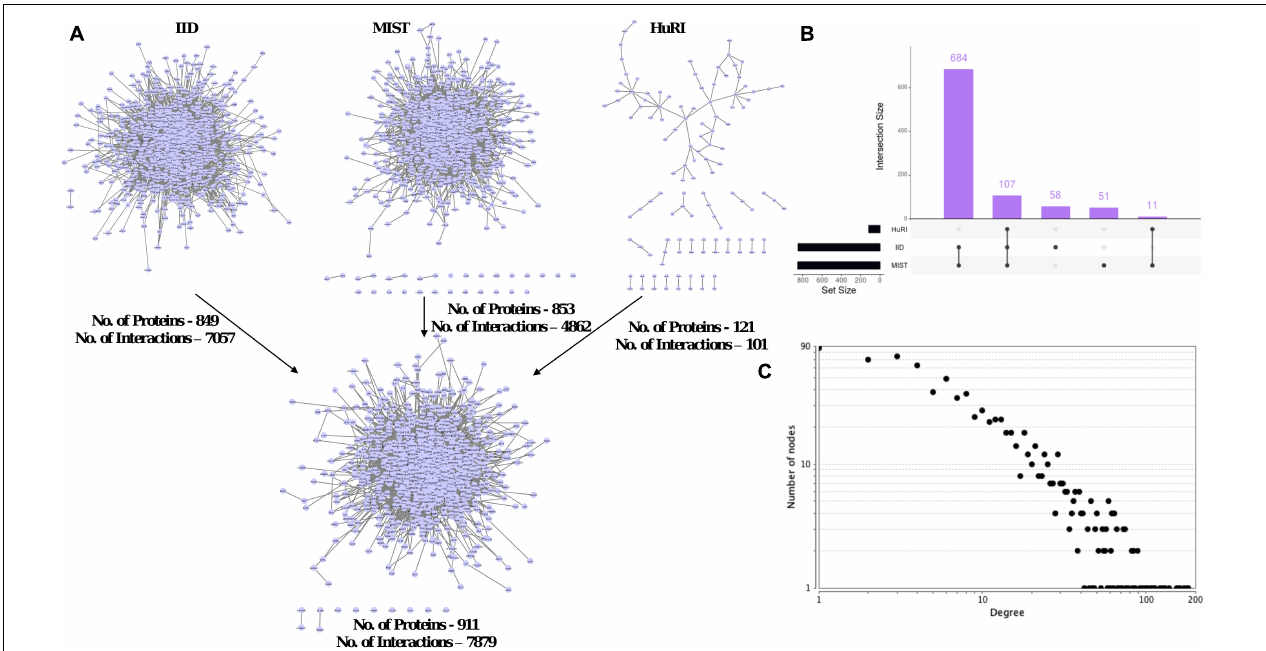
FIGURE 4 | Local-PPIN of aging and longevity related genes in human. (A) Three human protein interactomes – IID (Kotlyar et al., 2019), MIST (Hu et al., 2018), and HuRI (Luck et al., 2020) were compared to map the interactions within the aging and longevity related genes. A union of all above three interactomes identified 911 genes are physically interacted with each other at protein level (7879 local-interactions). (B) Overlapping of aging and longevity related genes in three human interactomes present in the local-PPIN. (C) A scale-free degree distribution graph for 911 genes in the local-PPIN related to aging and